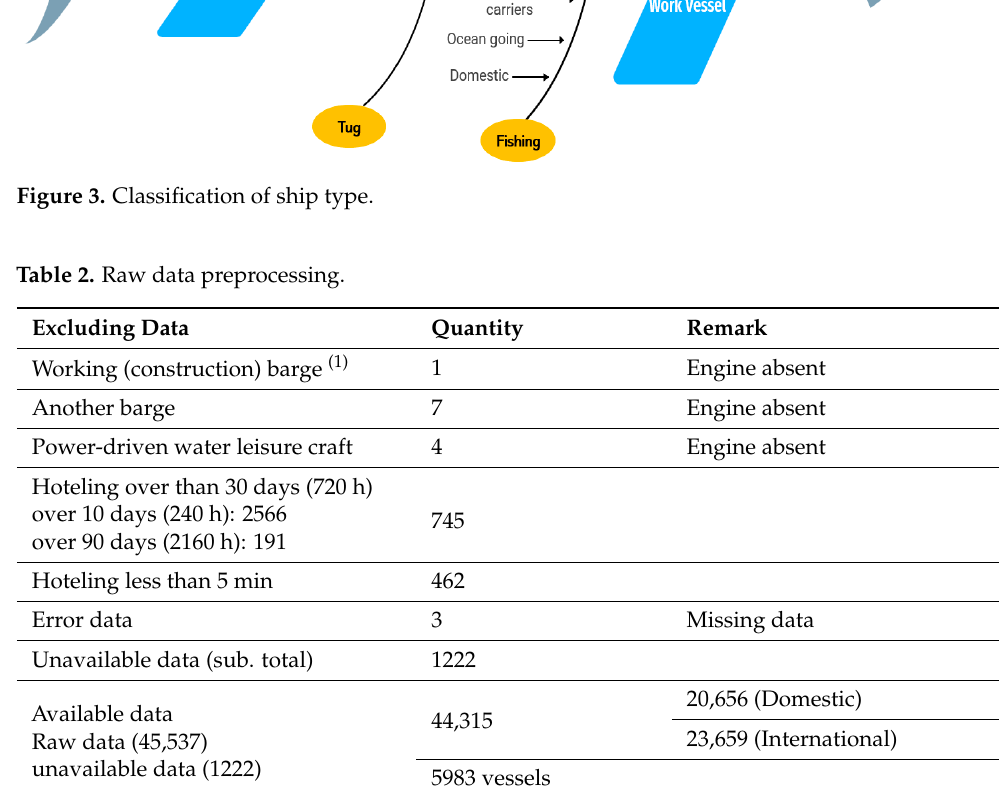
Table 2. Raw data preprocessing.